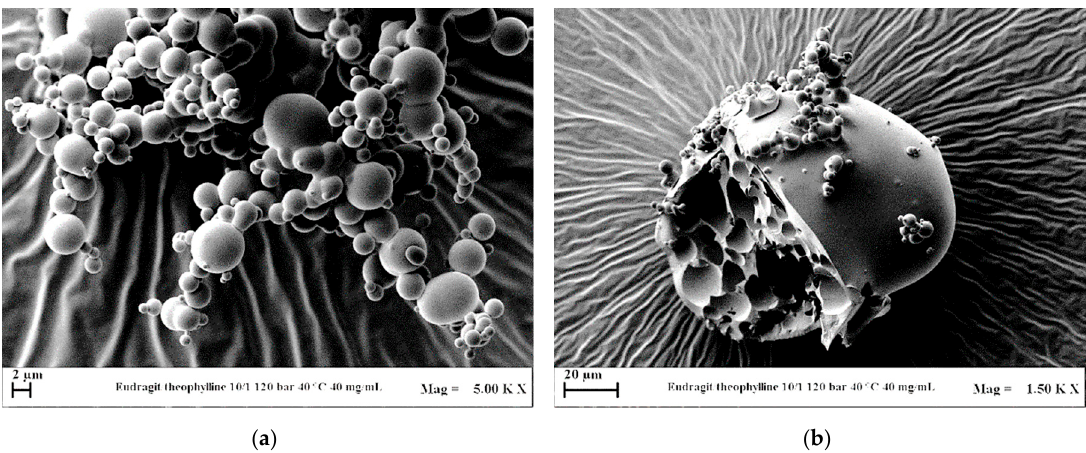
Figure 9. FESEM images of EUD/THEOP 10/1 w / w precipitated from DMSO at 40 °C, 12 MPa and 40 mg/mL (run #17). ( a ) Microparticles and ( b ) expanded microparticles.